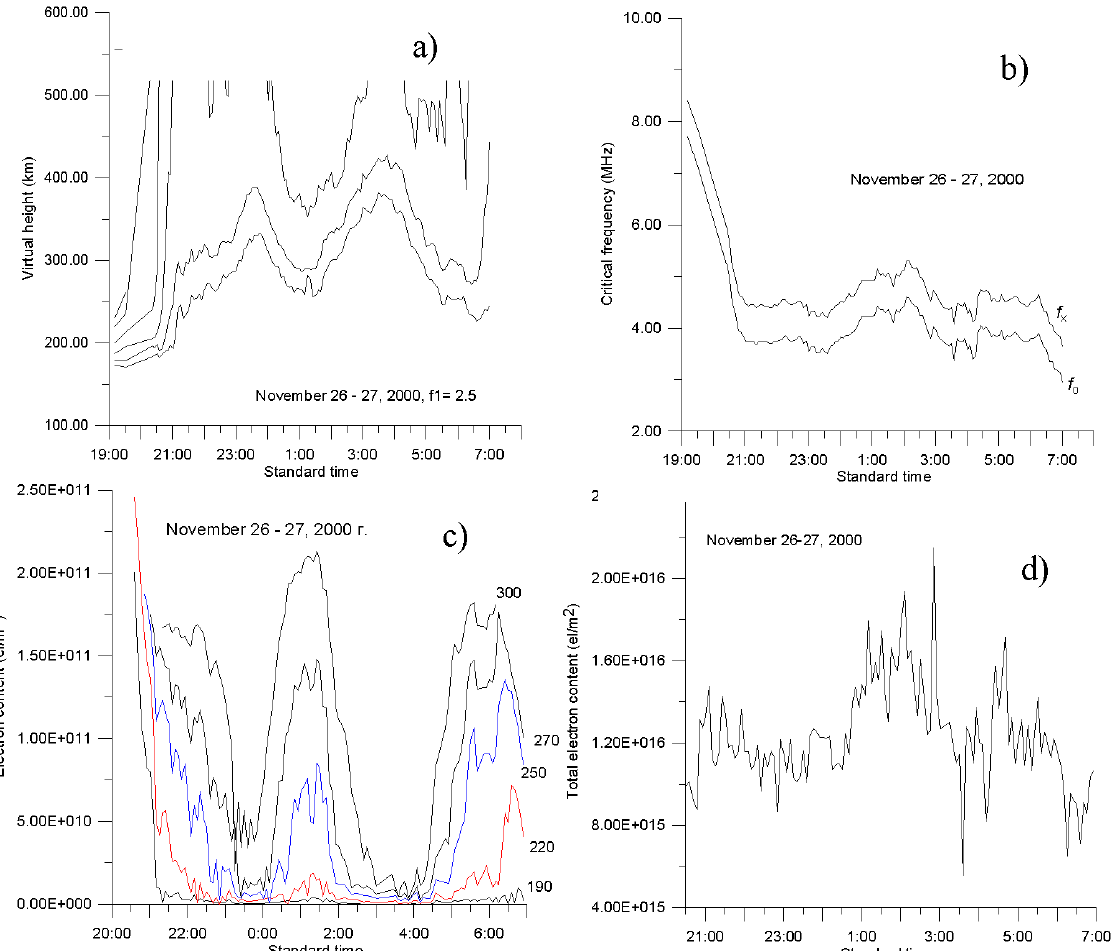
Fig. 1. Plots of the temporal variations of: (a) virtual heights ( x -component of the ionospheric signal) corresponding to specific frequencies of 2.5MHz, 3.5MHz, 4.5MHz, 5.5MHz, and 6.5MHz, (b) critical frequencies of the ordinary ( f o ) and extra-ordinary ( f x ) components, (c) the electron content at series of heights h = 190km, 220km, 250km, 270km, and 300km, (d) the total electron content below the F-layer